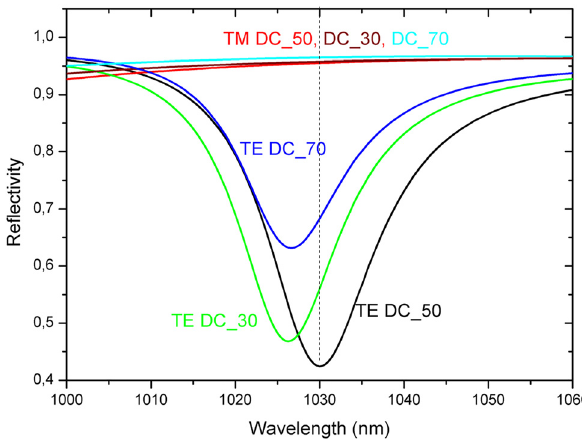
Figure 4: Calculated reflectivities for TE and TM polarized radiation ofGWOCSwithagratingdutycyclesof30,50(nominaldesignvalue) and 70%.